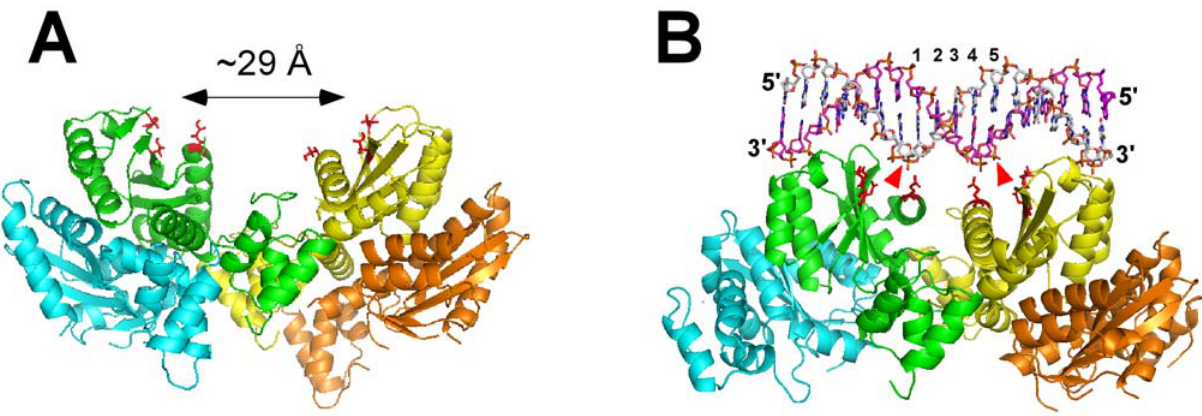
Figure 3. Molecular models for two distinct forms of HIV-1 IN tetramers. (A) An “open” conformation of tetrameric IN. This model is based on the HIV-1 IN two domain (NTD- CCD) structure [41] and our MS footprinting results [48] indicating that such a conformation is stabilized by LEDGF/p75 in the absence of viral DNA. This “open” conformation of tetrameric IN could catalyze 3’-processing and half-site integration reactions, however an incorrect spacing (~29 Å) between the two active sites would hamper the concerted integration. (B) A “closed” conformation of HIV-1 IN tetramer. This model was built by Hare et al. using one of the crystal forms of the MVV IN structure [47], where the catalytic sites are positioned optimally for concerted integration. It has been proposed that this structure could be stabilized by two viral DNAs [47]. However, viral DNAs have not been included in the model. Instead, the relative positioning of two catalytic sites with respect to the target DNA is shown to demonstrate the 5 bps separation consistent with a pair-wise integration. Red arrows point to the target scissile bonds. Individual subunits are colored cyan, green, yellow and orange. Side chains of catalytic residues in green and yellow subunits are depicted in red. For clarity only NTD-CCD fragments are depicted, while the CTDs, which are also present in these models [47,48], are not